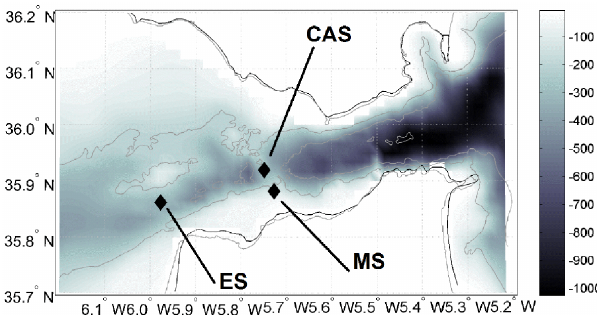
Fig. 2. Location of the three monitoring sites at Gibraltar (ES=Espartel Sill; CAS=Camarinal Sill; MS=Moroccan